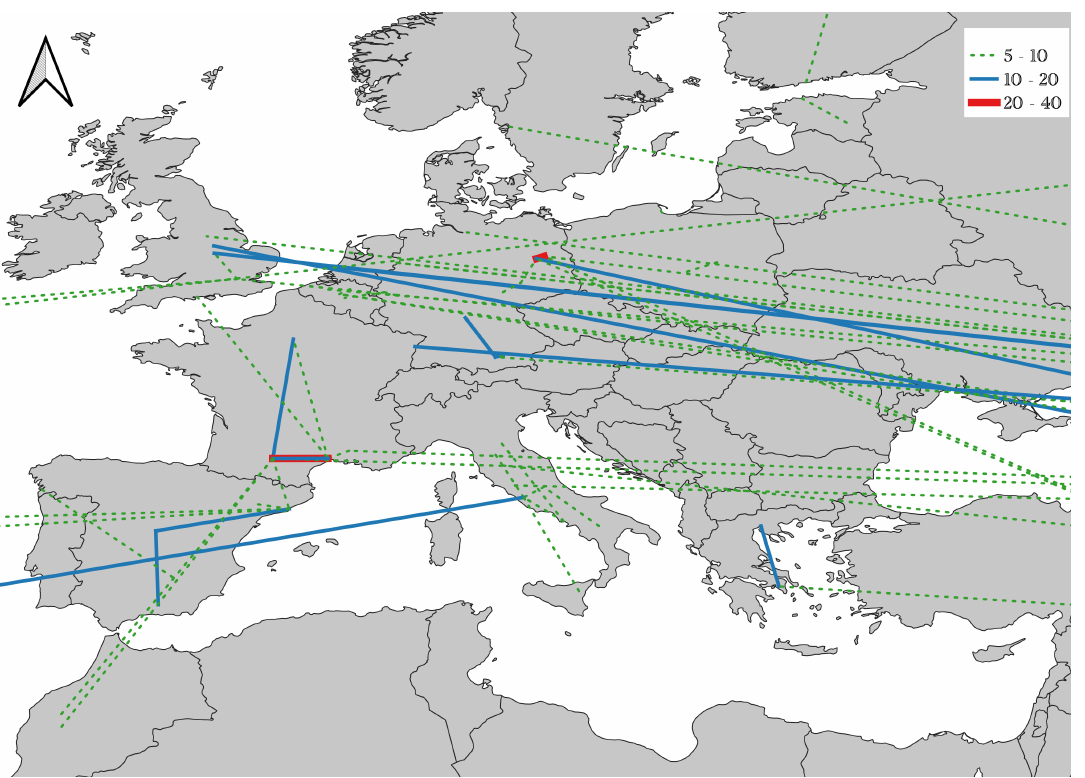
Figure 17. Connections of affiliations of articles published in Remote Sensing with an affiliation in the EU and the